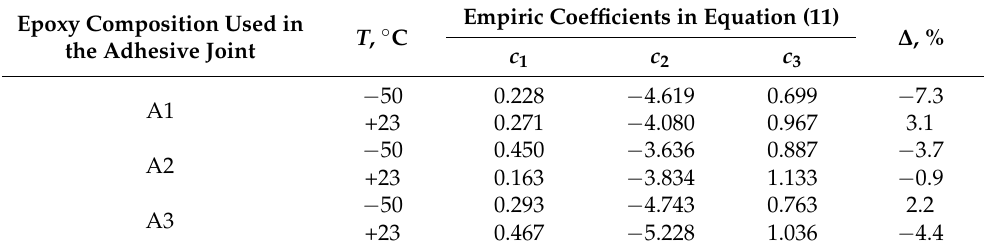
Table 4. Approximation coefficients in Equation